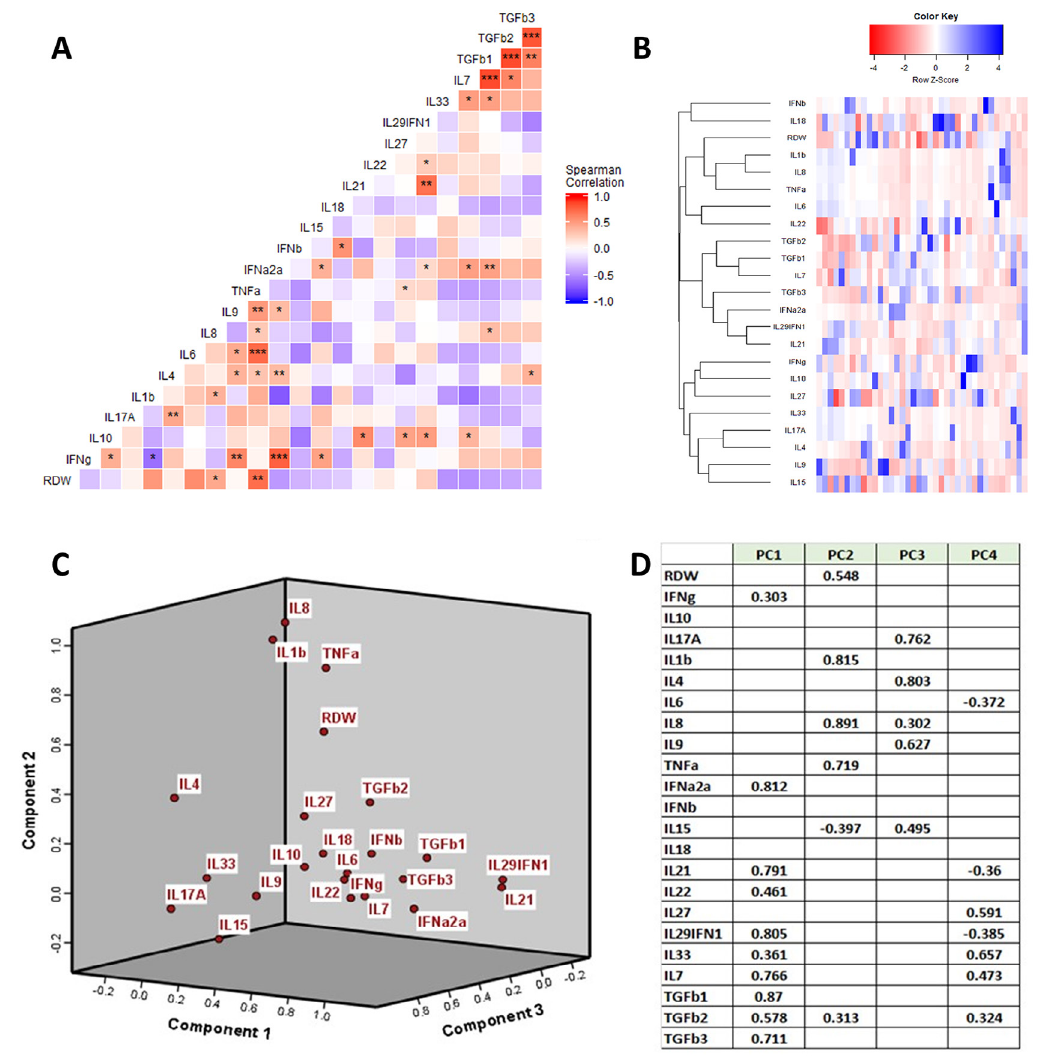
Figure 4. Anisocytosis in 38 Uninfected Ambulatory Adults Without Cardiovascular Disease Is Associated With a Pro-inflammatory Milieu (A) correlation matrix between RDW and cytokine profile (Spearman correlations: * P <0.05, ** P <0.01), (B) hierarchical clustering showing that RDW clusters with IL1-beta, IL-6, and TNF-alpha, (C) Component plot showing that RDW clusters with TNF-alpha and IL1-beta, (D) Principal Component Analyses showing that RDW clusters with IL-1beta, TNF-alpha, and